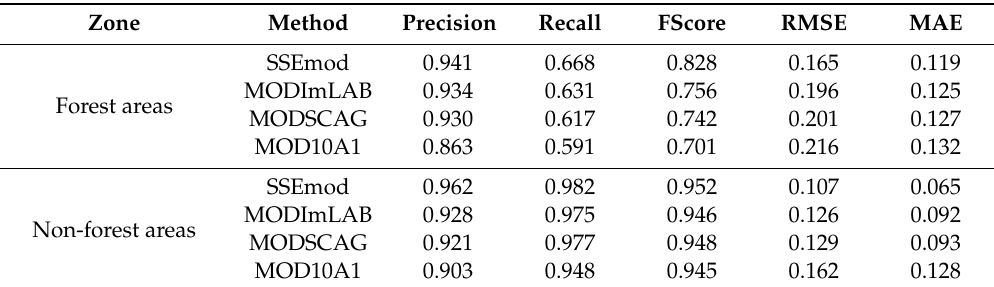
Table 2. The accuracy validation of binary and fractional metrics of FSC retrieved by the spectral mixture analysis models and semi-empirical linear model in forest areas and non-forest areas of the three main snow-covered regions of China.